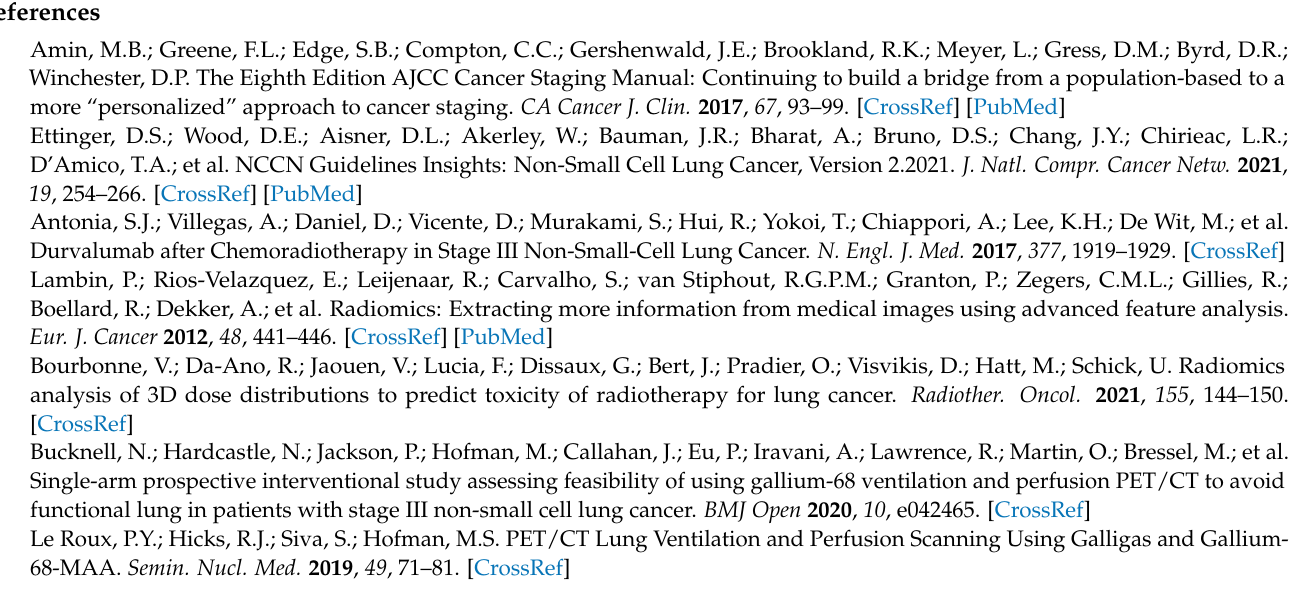
Correlation of each feature with the APT 2 risk (training cohort), Supplementary Table S4: Analysis of the each model’s discrimination between patients with or without APT ≥ grade 3 in the training set, Supplementary Table S5: Analysis of the each model’s discrimination between patients with or without APT ≥ grade 3 in the testing set, Supplementary Figure S1: Overlap between the PmapRad and Pmap maps, Supplementary Figure S2: Comparison between each model in the testing sets based on the precision-recall curve for the prediction of APT ≥ grade 2, Supplementary Figure S3: Comparison between each model in the testing sets based on the calibration curve for the prediction of APT ≥ grade 2, Supplementary Figure S4: Comparison between each model in the training (a) and testing (b) sets, based on the ROC curve for the prediction of APT ≥ grade 3, Supplementary Figure S5: Comparison between each model in the training (a) and testing (b) sets, based on the decision curve analysis for the prediction of APT ≥ grade